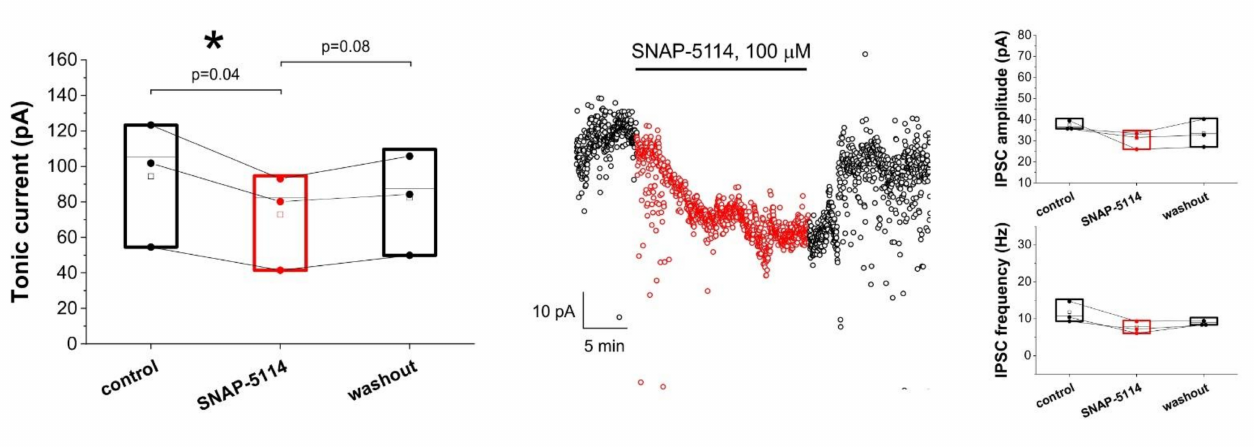
Figure 1. Glial GABA transporters release GABA and generate tonic inhibition in low-[Mg 2+ ] ACSF. Left: Box-chart representation of GABA ergic baselines during control condition, in the presence of SNAP-5114 and washout. Box edges represent 25th, 50th and 75th percentile, open squares represent means, circles connected by lines represent paired individual baseline values. (N = 3). Middle: baseline currents plotted at 1 s intervals in a selected experiment. Right : amplitude and frequency of inhibitory postsynaptic currents (IPSCs). Box edges represent 25th, 50th and 75th percentile, open squares represent means, circles connected by lines represent paired individual baseline values. (N = 3). Neither amplitude, nor frequency changed significantly due to SNAP-5114 application ( p = 0.31 and p = 0.29, respectively). Black symbols represent control and washout periods, red symbols represent SNAP-5114 application in all